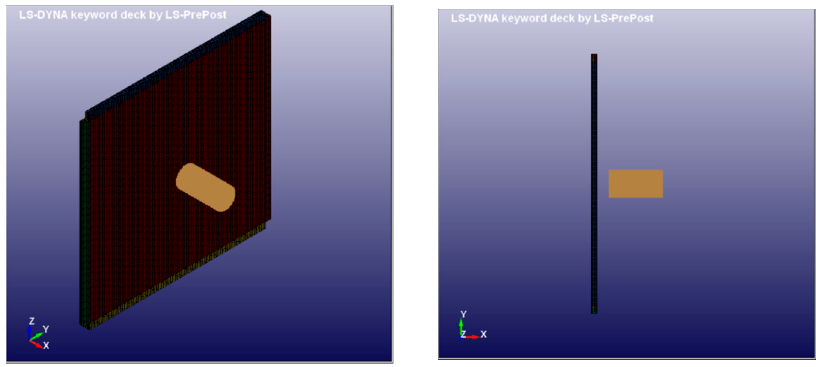
Figure 8. Simplified model to estimate the bird-strike.